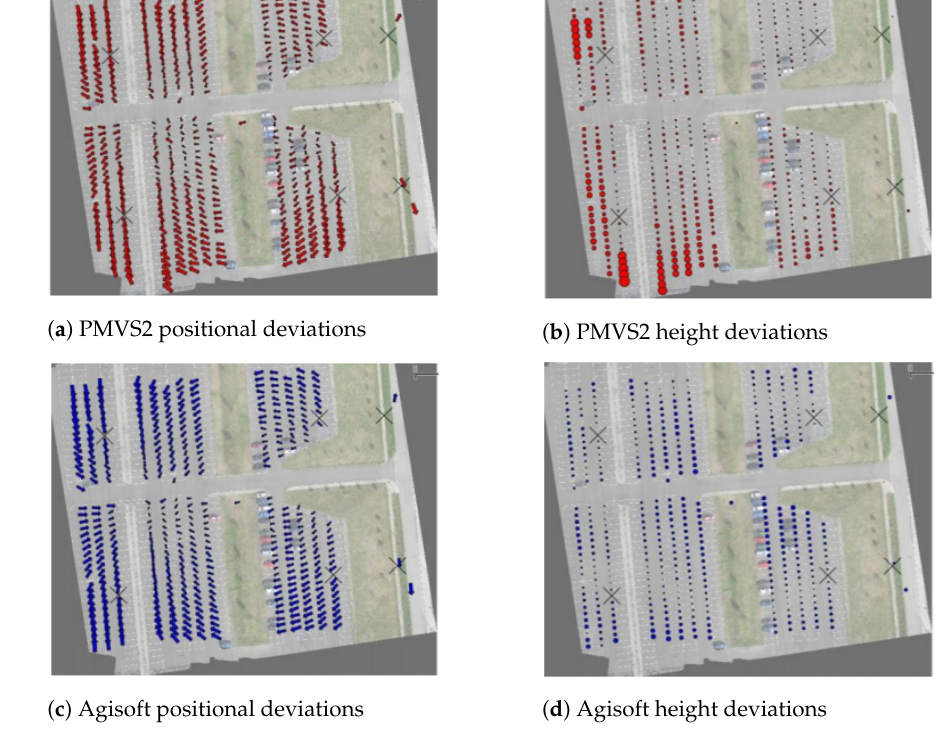
Figure 3. Positional and height deviations comparisons between the results obtained from PMVS2 and Agisoft. The vectors illustrated on the ( a , c ) represent the deviations in position of points. Larger vector sizes indicate a larger deviation. The circles on ( b , d ) describe the height deviations of points, where larger circles represent larger height deviations. Additionally, the crosses illustrate reference markers. Adapted from